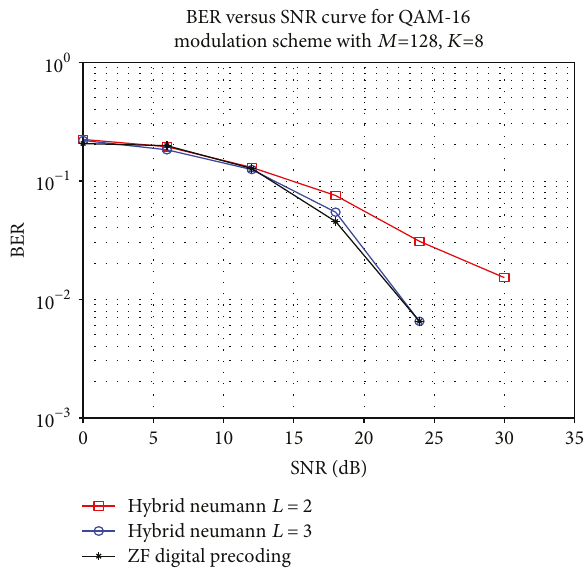
Figure 2: BER performance of hybrid precoding in urban micro cell scenario for 128 × 8 massive MIMO